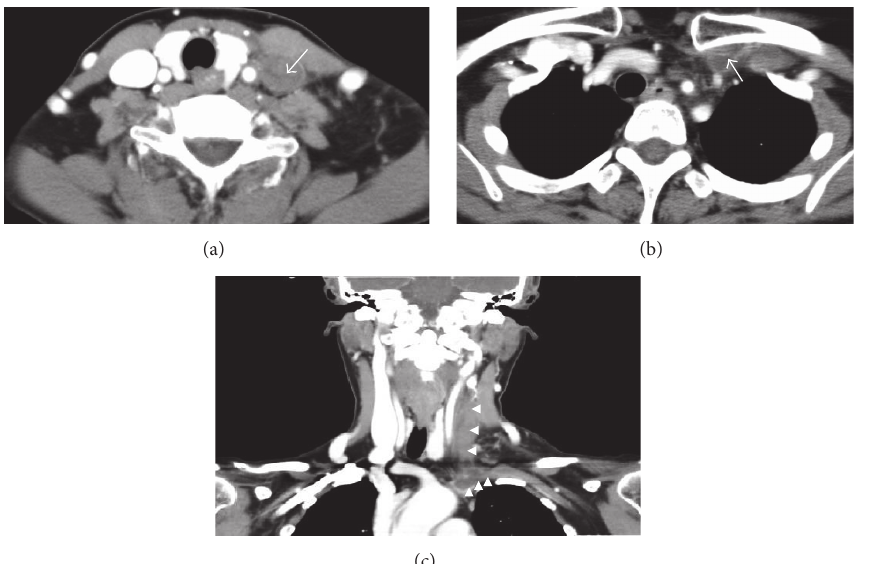
Figure 1: Axial enhanced CT image of soft tissue of the neck (a), the chest (b), and coronal enhanced CT image of soft tissue of the neck (c). There are filling defect in the left internal jugular vein (a) and subclavian vein (b), with the lumen filled with dense soft tissue (arrow). A vascular filling defect is noted in the region extending from the left internal jugular vein to the left subclavian vein, and the venous lumina are filled with dense soft tissue (arrowhead).